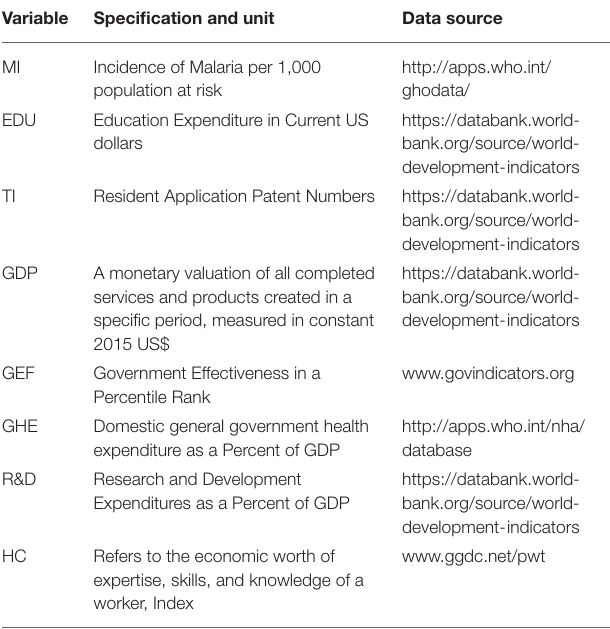
TABLE 2 | Variables, their specifications, units, and sources.